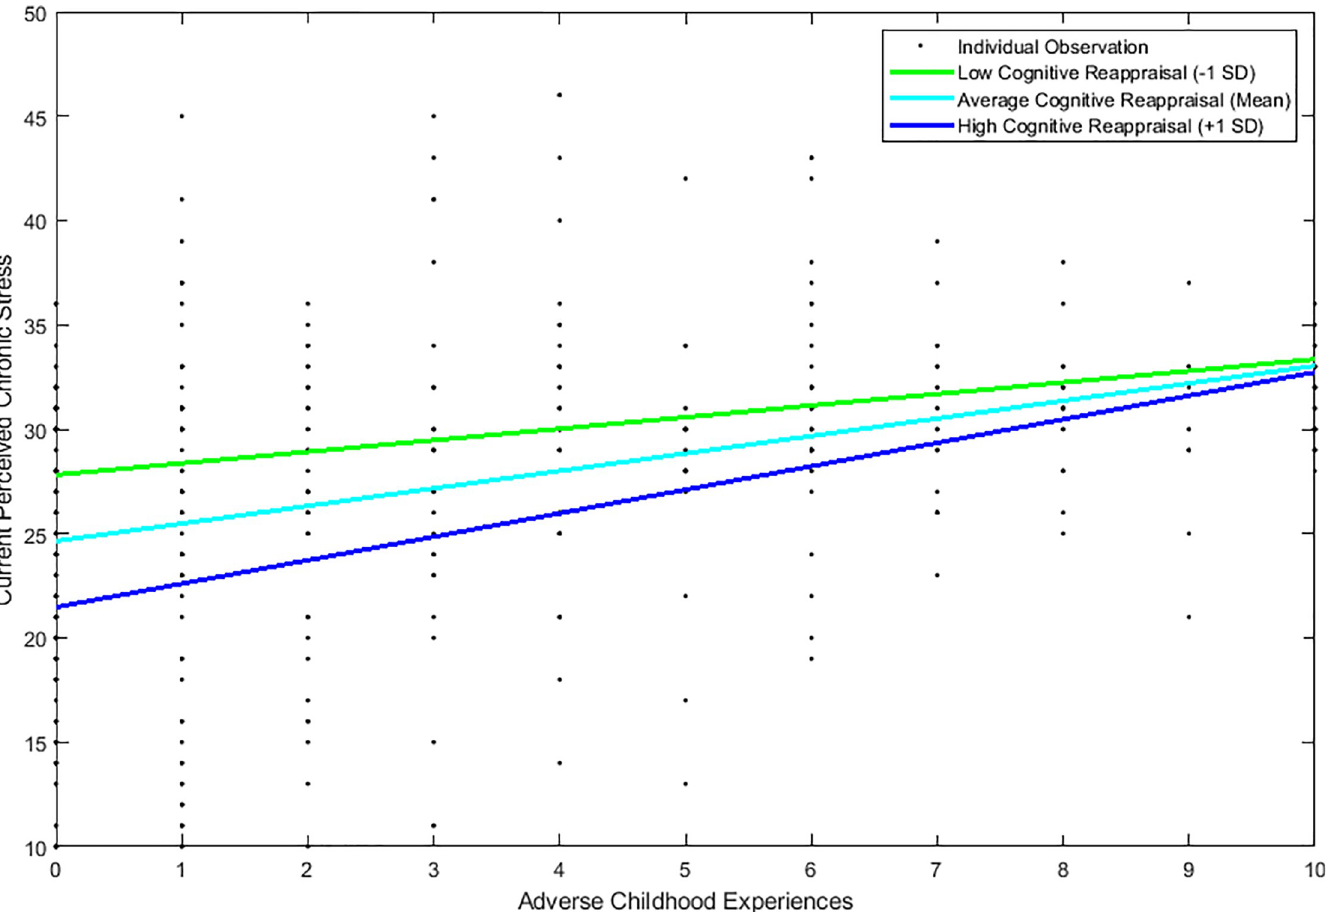
Fig 2. Relation between ACEs and PSS at high, average, and low levels of cognitive reappraisal.